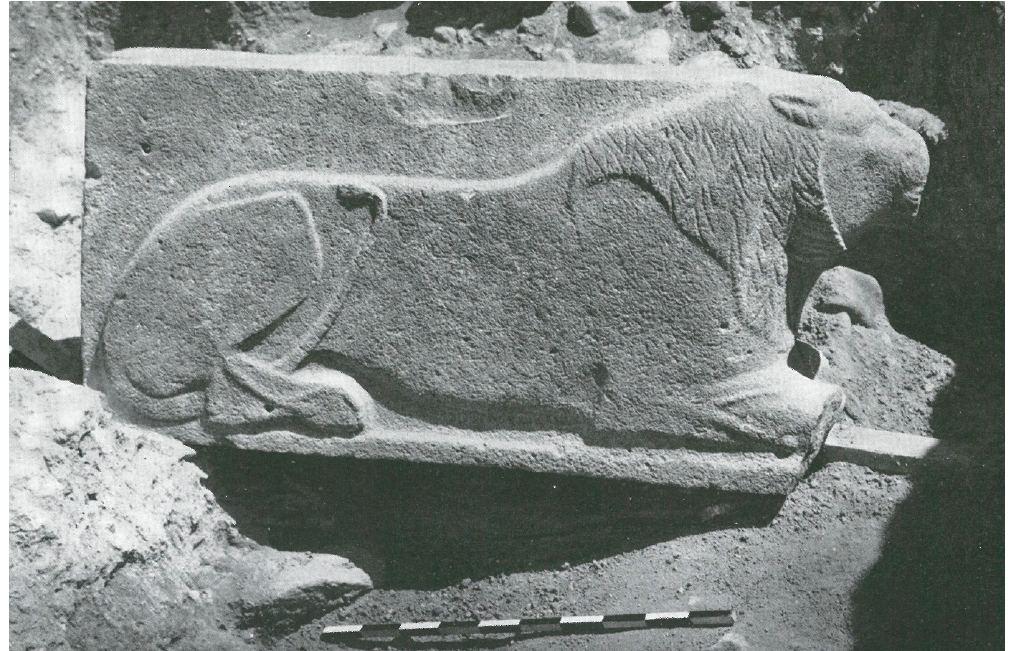
Figure 3. Basalt orthostat depicting a lion from the Area H temple at Hazor (From Yadin 1961: Plate CXX:2; courtesy of Amnon Ben-Tor and the Israel Exploration Society). CXX:2; courtesy of Amnon Ben-Tor and the Israel Exploration